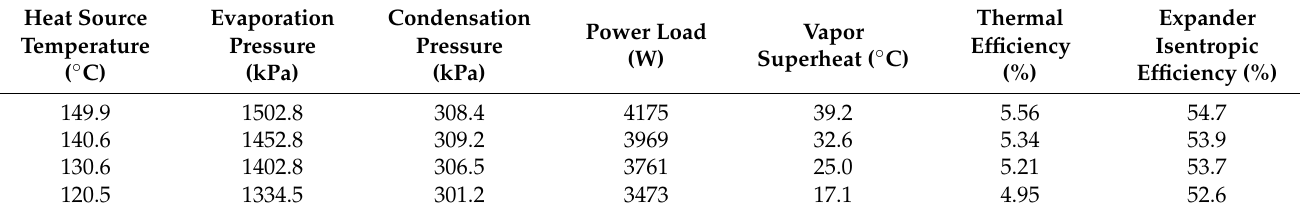
Table 5. Off-design performance of the ORC prototype with decreasing heat source